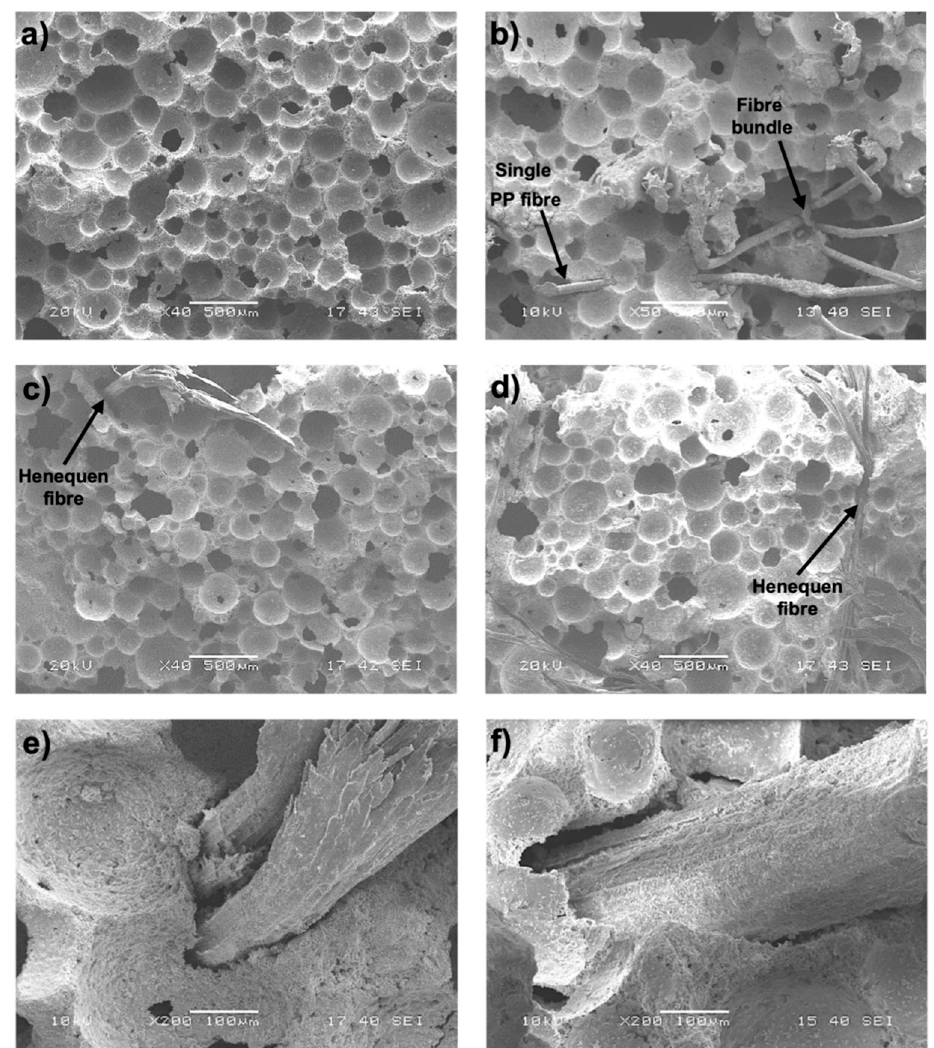
Figure 7. SEM images of fiber-reinforced foamed concrete (FRFC): ( a ) PFC; ( b ) PP1.5FC; ( c ) H1.5FC; ( d ) HT1.5FC; ( e ) single untreated henequen fiber in the FRFC and ( f ) single treated henequen fiber in the FRFC.